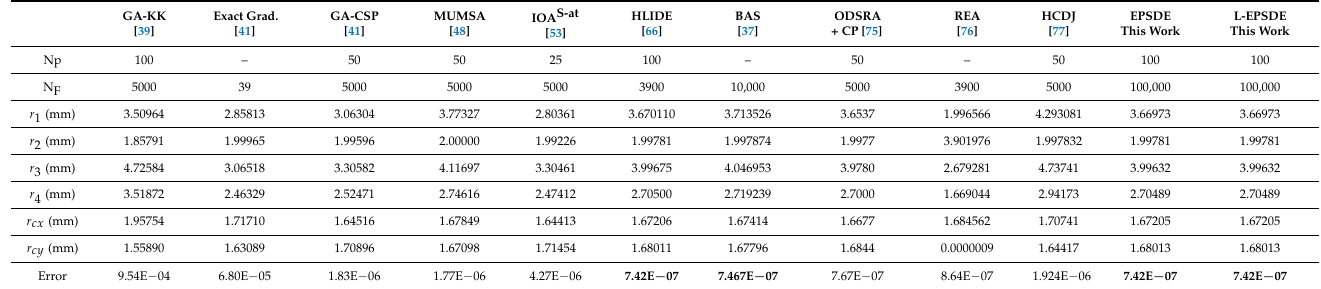
Table 3. Optimal results of EPSDE, L-EPSDE, and ten other optimization methods for Case 1.